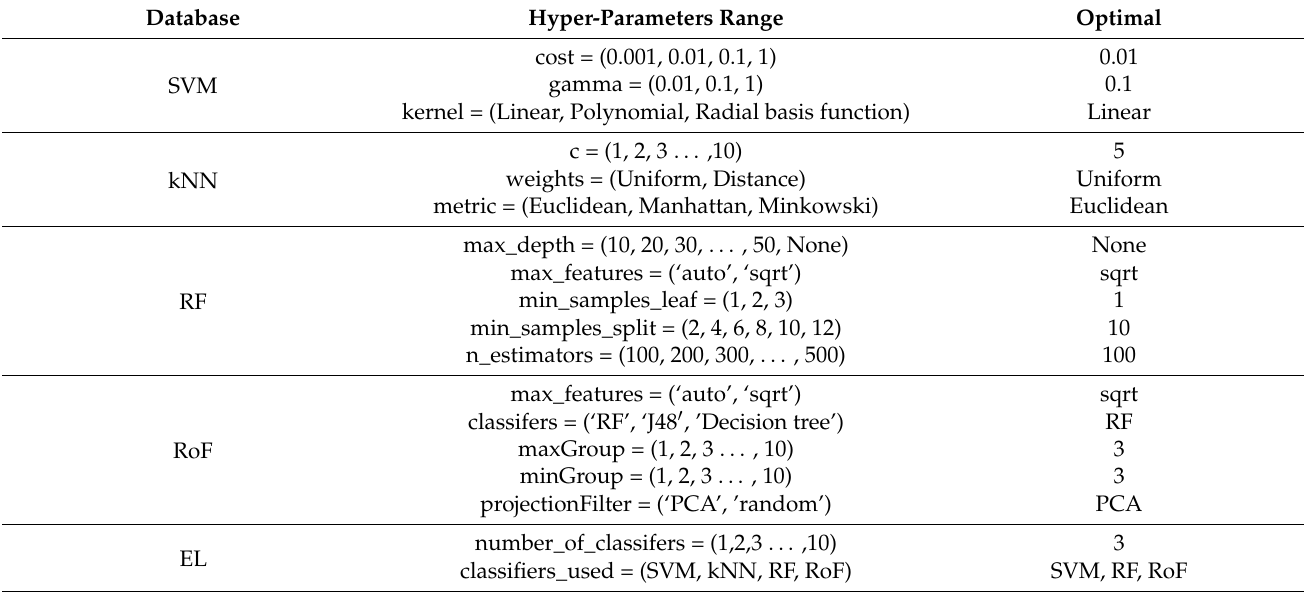
Table 2. Optimal parameters for each